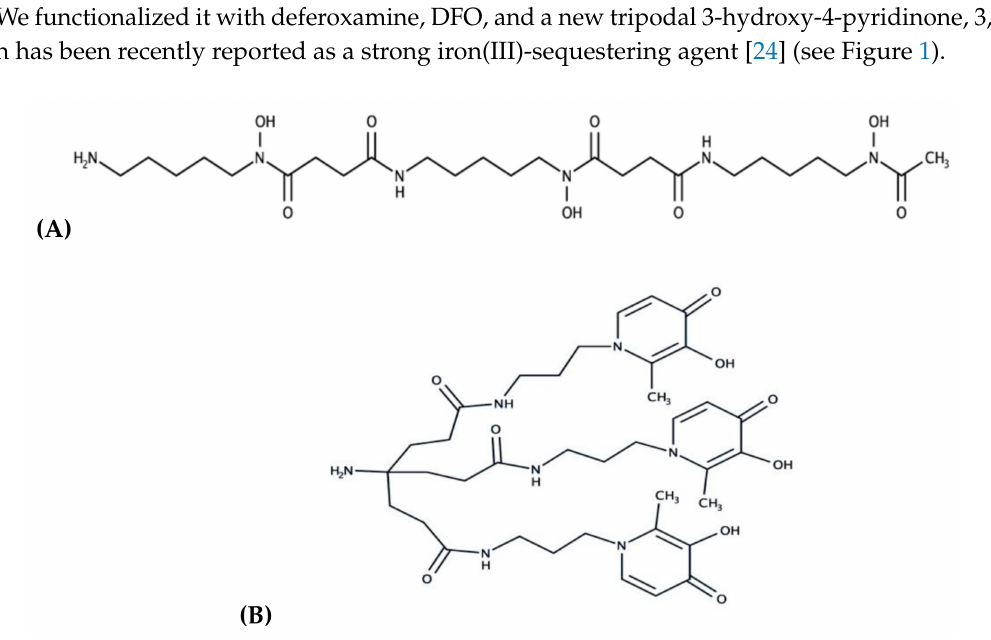
Figure 1. Structure formulae of ( A ): deferoxamine (DFO) and (B ): tris 3-hydroxy-4-pyridinone (3,4-HP). Conventional physico-chemical methods are used to characterize both functionalized materials. The isotherm profiles and the complexing properties towards Fe(III) of the new solid polymers are presented and